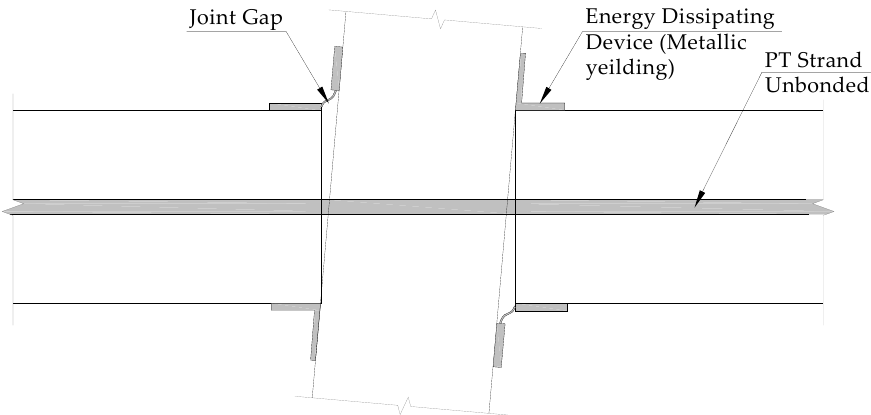
Figure 29. The proposed precast post-tensioned beam column connection (deformed) [54].